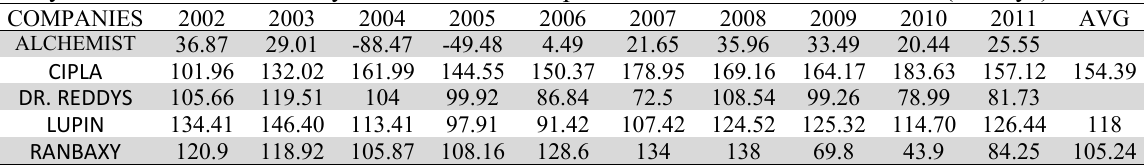
Analysis of cash conversion cycle of selected companies of Pharmaceuticals sectors(in Days)